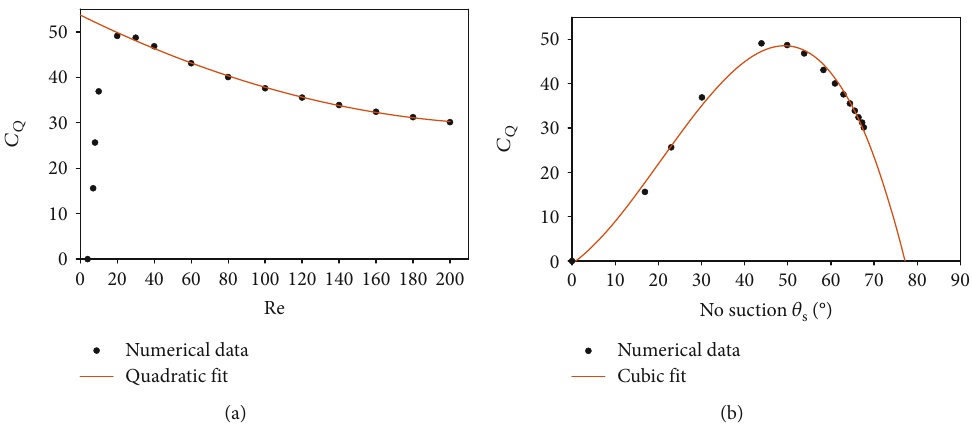
Figure 5: Minimum suction coe ffi cient necessary to prevent separation (a) against Reynolds number and (b) against the separation angle without control.